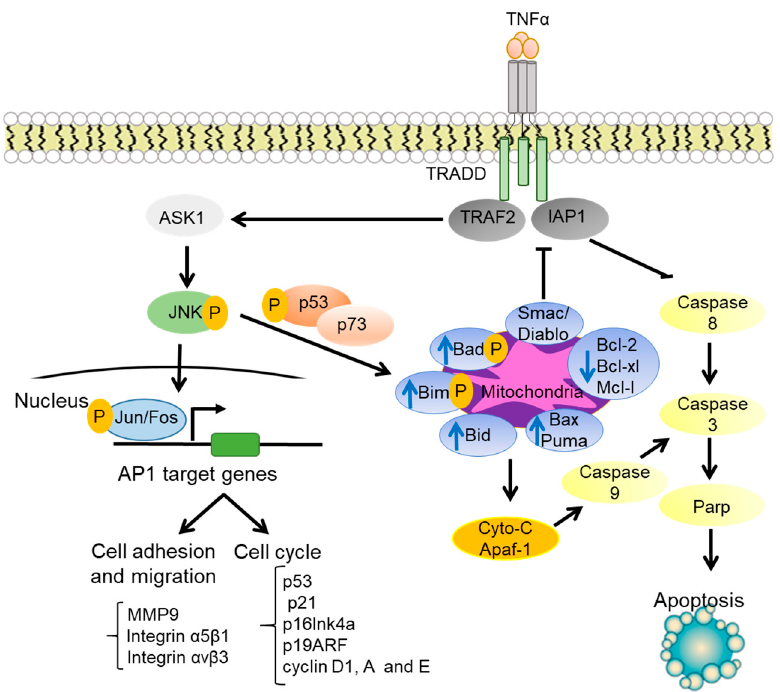
Figure 2. JNK regulation of cell cycle progression, cell adhesion, and cell apoptosis. In response to extracellular cytokines such as TNF α , JNK induces the phosphorylation of p53 and activation of p73. This process leads to the upregulation of the proapoptotic proteins (e.g., Bad, Bim, Bid, Bax, Puma) and Smac/Diablo and the downregulation of the antiapoptotic proteins (e.g., Bcl-2, Bcl-x, and Mcl-1). In parallel, JNK regulates cell cycle, cell adhesion, and cell migration through the activation of AP1 target genes.